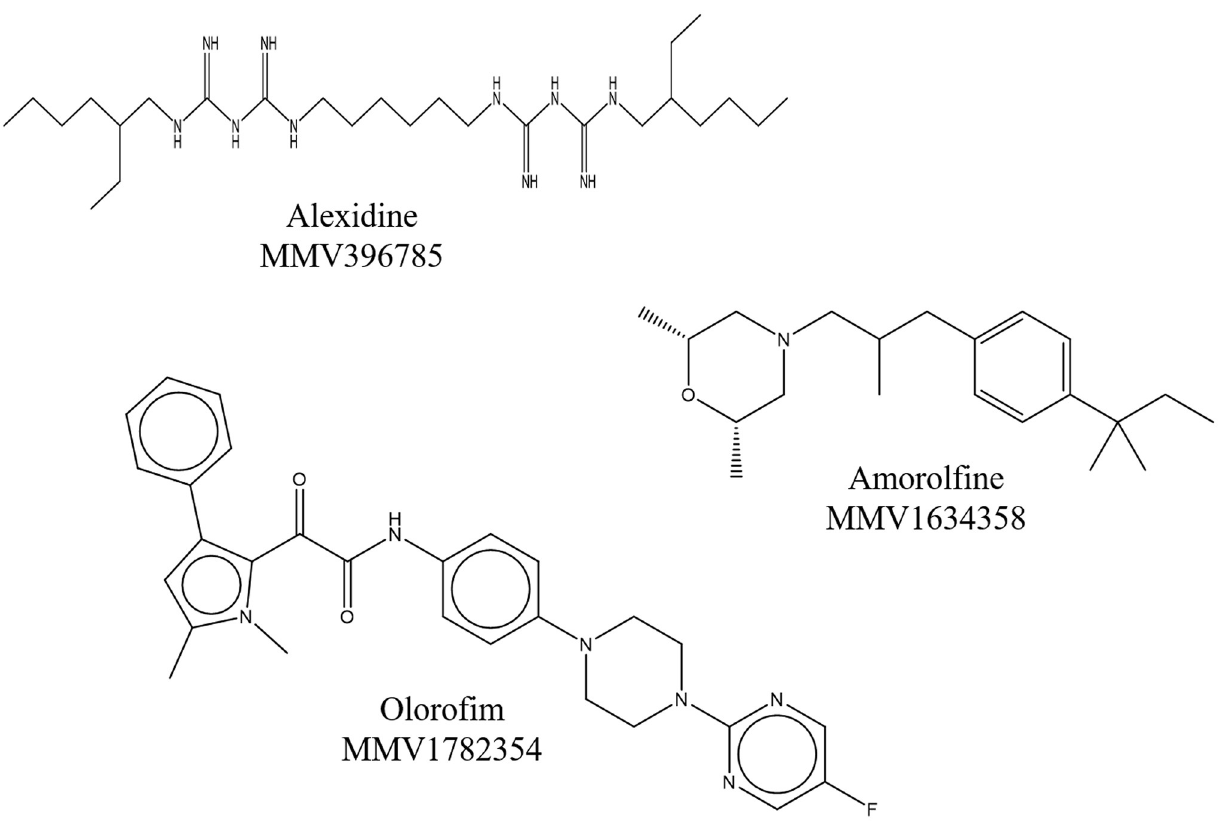
Fig 2. Molecular structures of the compounds with activity against Scedosporium and Lomentospora species. The compounds present in MMV Pandemic Response Box 1 library are MMV396785 (Alexidine), MMV1634358 (Amorolfine) and MMV1782354 (Olorofim).